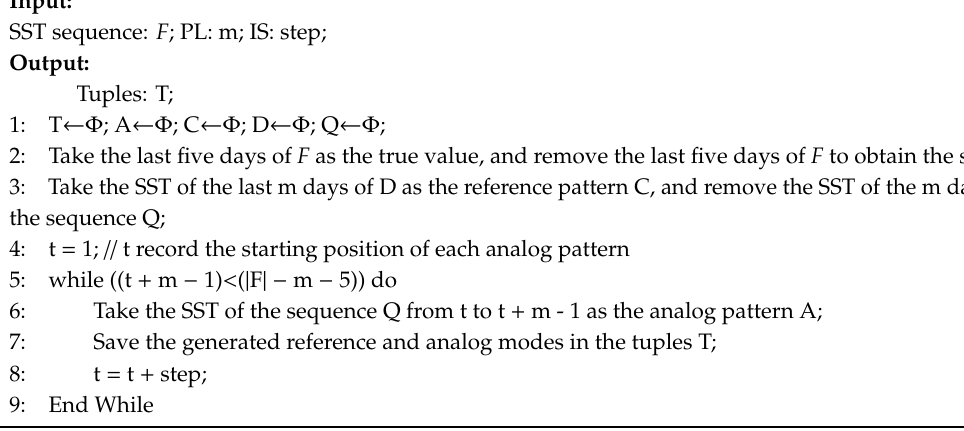
Algorithm 1. Generating the reference pattern C and the analog pattern